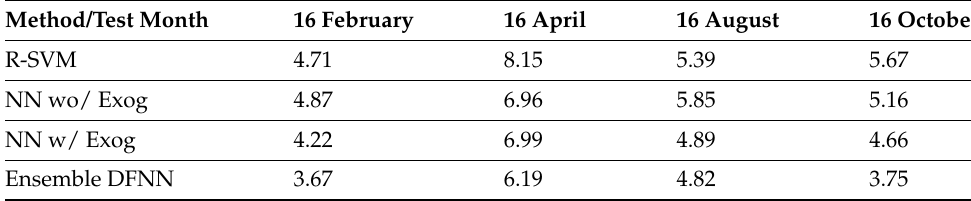
Table 3. Comparison of one day-ahead NE Load Forecasting results: MAPE